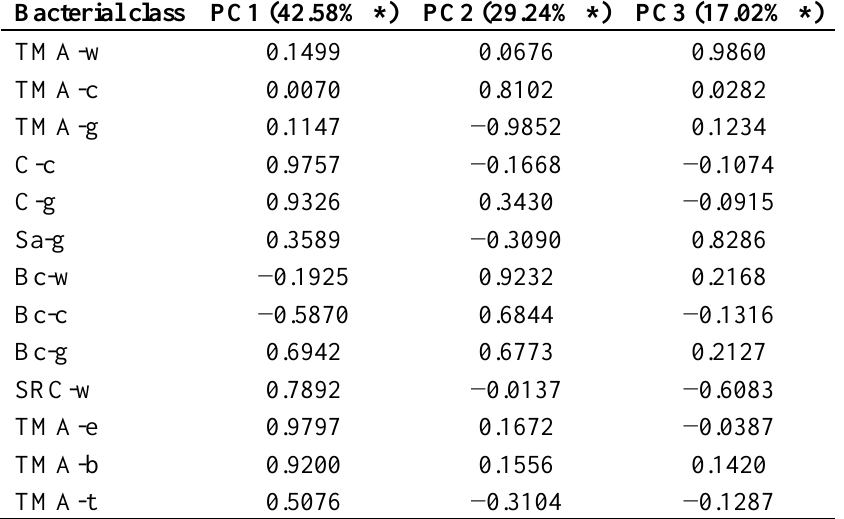
Table 4. Percentage of explained variance and eigenvector coefficients concerning the three main principal